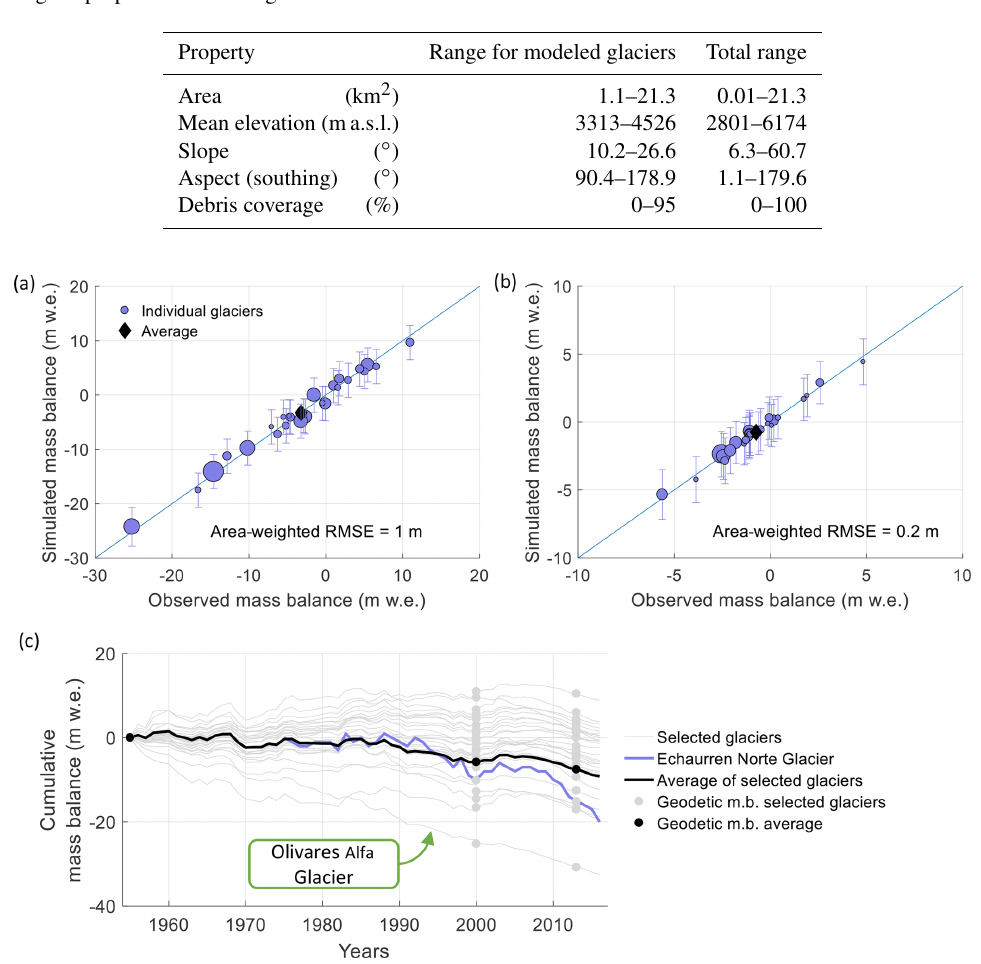
Figure 4. Results of the calibration for the 26 modeled glaciers. Glacier-averaged mass balance (blue circles) simulated with TOPKAPI- ETH and observed from geodetic mass balances in the period (a) 1955–2000 and (b) 2000–2013. The area-weighted average of all glaciers is indicated with black diamonds. The blue bars show the uncertainty of the geodetic mass balances. (c) Cumulative 1955–2016 mass balance for each modeled glacier (grey lines), the area-weighted average of all glaciers (black line), and the mass balance measured on Echaurren Norte Glacier (blue line) are also shown. The geodetic mass balances for each modeled glacier is indicated with a circle. The curve corresponding to the fastest retreating glacier of the sample, Olivares Alfa Glacier, is